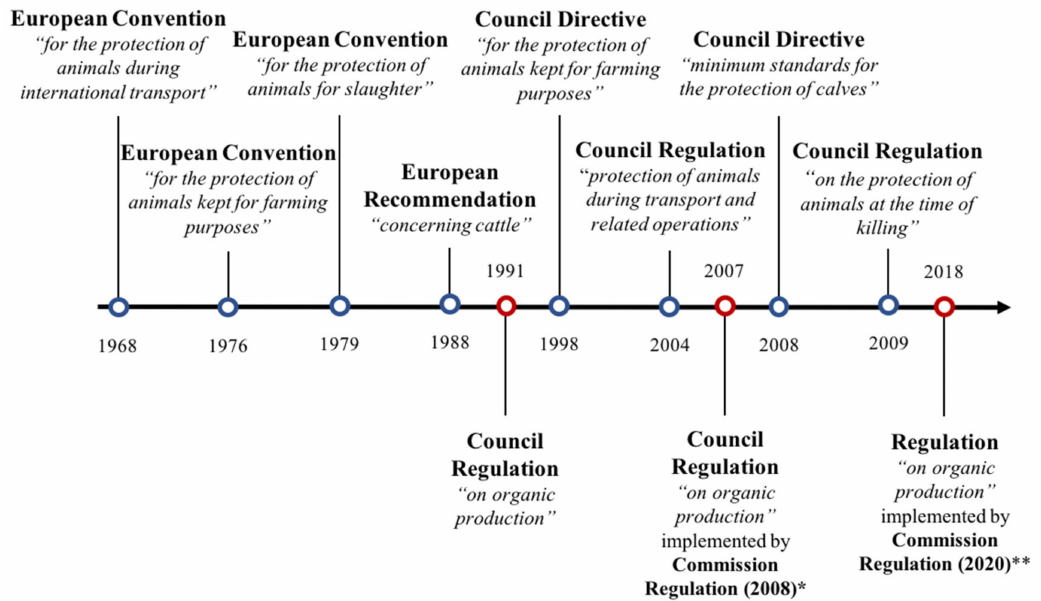
Figure 1. Timeline of European legislation (for conventional and organic farming) with regard to dairy cattle welfare (current as of August 2020). Texts presented above (blue dots) apply to both conventional and organic farming but texts presented below (red dots) apply specifically to organic farms. Council directives have to be transposed by Member States in their national legal systems. In contrast, regulations for organic farming and for transportation and slaughtering are more detailed and binding as they are directly applicable in all Member States (no need for national